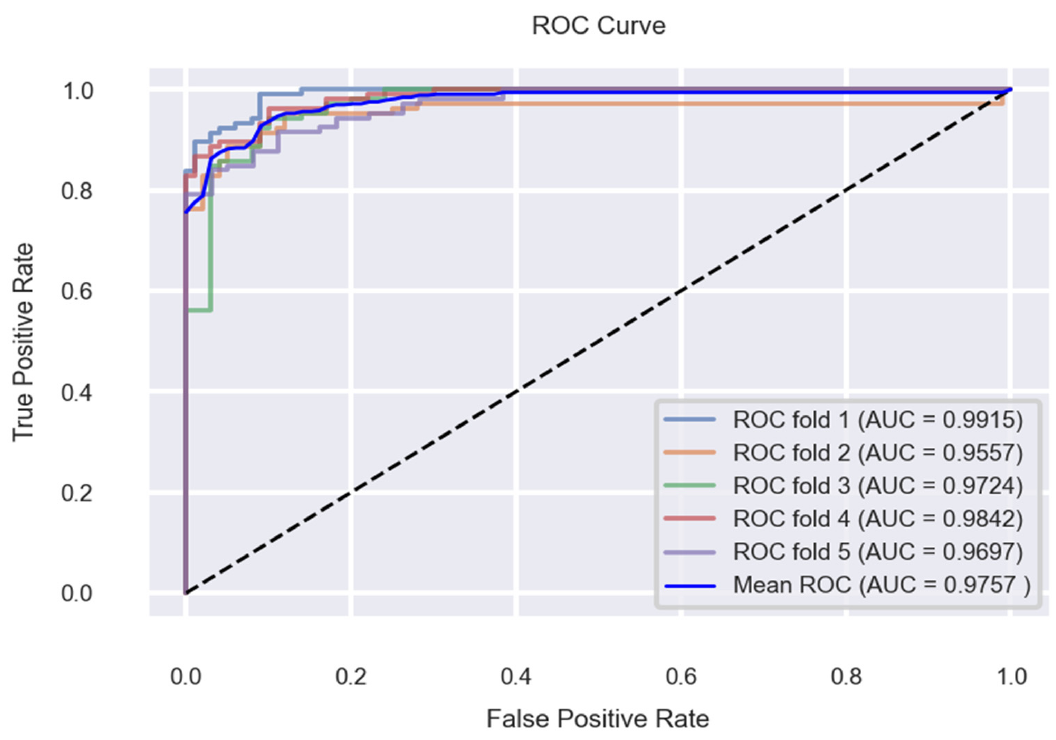
Figure 22. Stratified (K = 5)-Fold Cross-validation Results for Ada Boost Classifier (ROC-AUC).